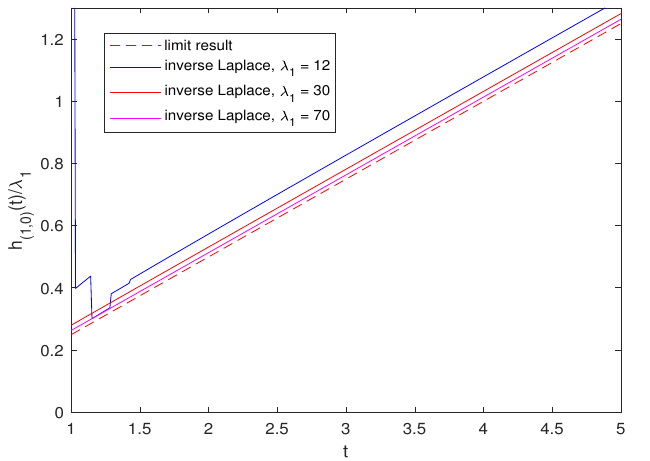
ˆ H ( 1,0 ) ( s ,0 ) of Equation (13) for different values of λ 1 . λ 1